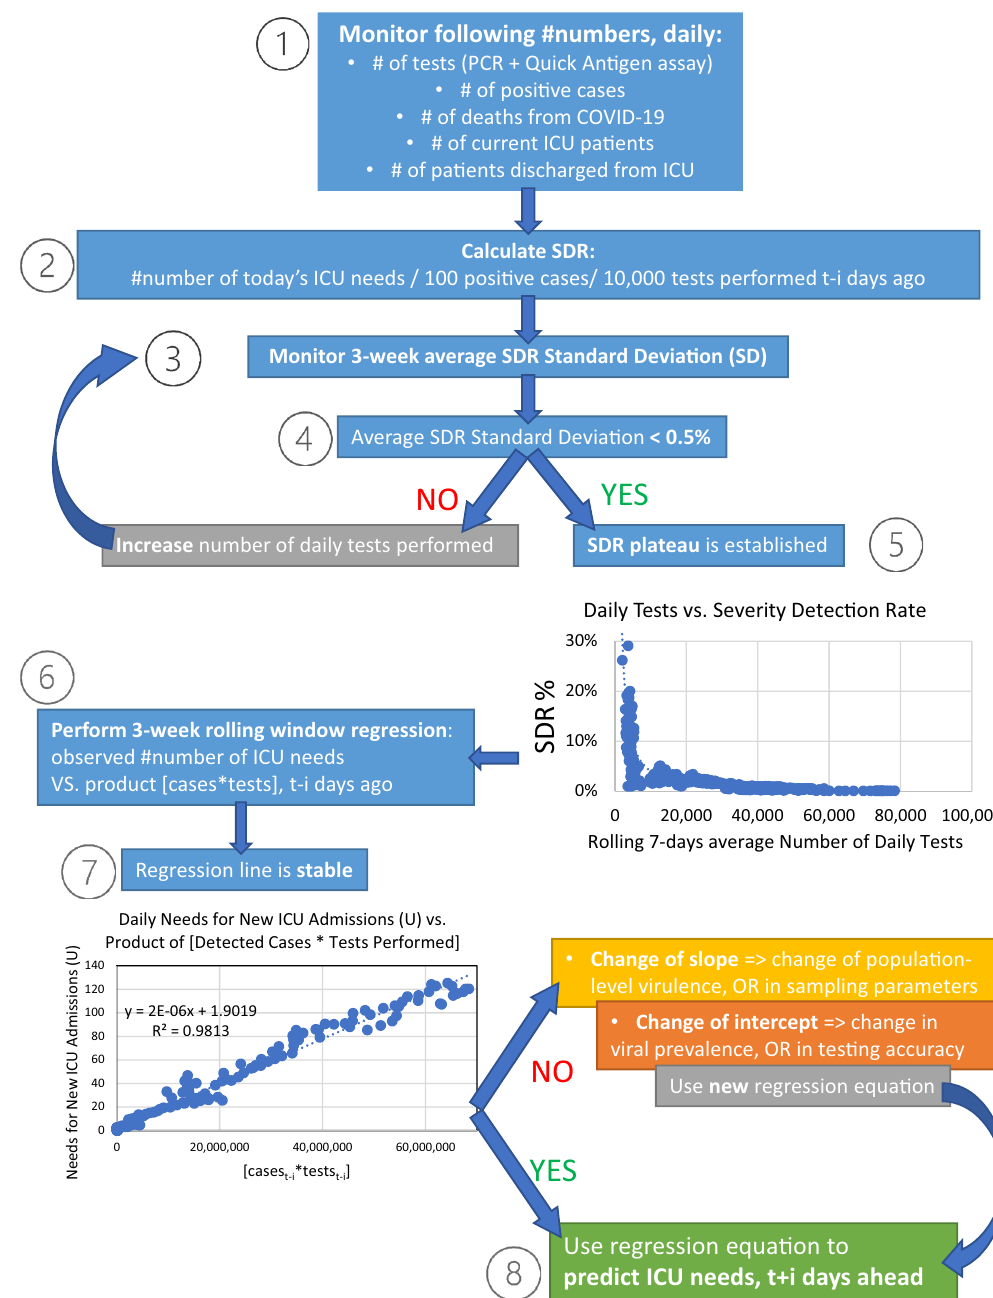
Figure 6. Stepwise schema detailing the logic and requirements for population-level surveillance of COVID-19 pandemic with the use of the Severity Detection Rate